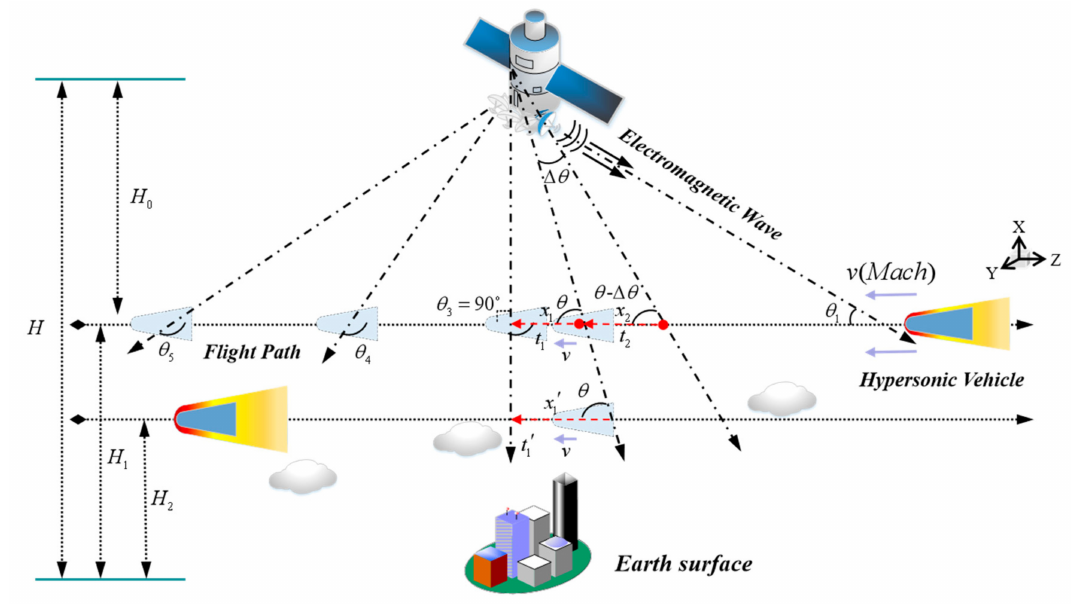
Figure 2. Hypersonic vehicle flying path and DRCS observation